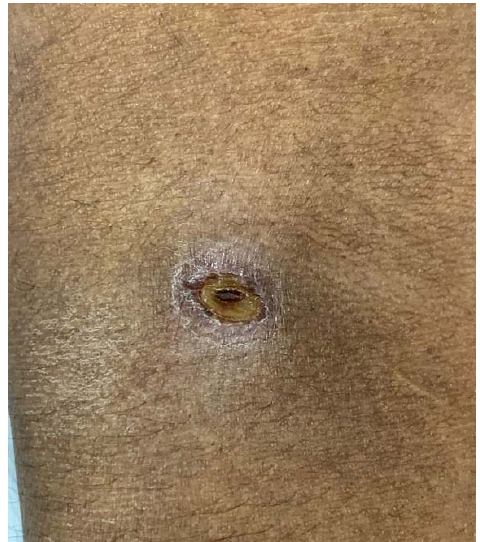
Figure 1. Eschar of scrub typhus (measuring 7 × 5